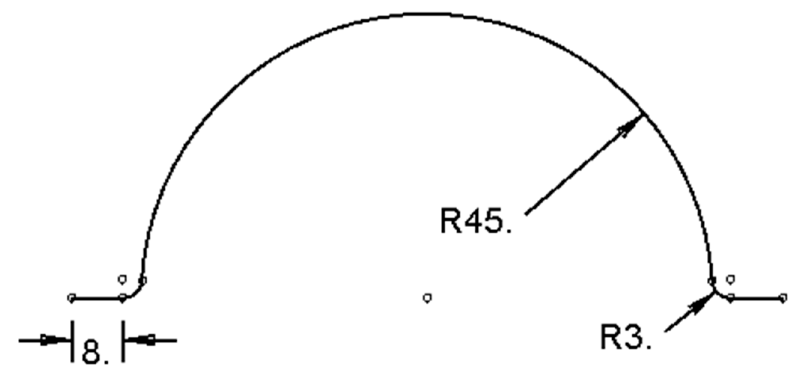
Figure 2. The schematic of the cross-section of the semi-circle specimen. (All dimensions are given in millimeters.)